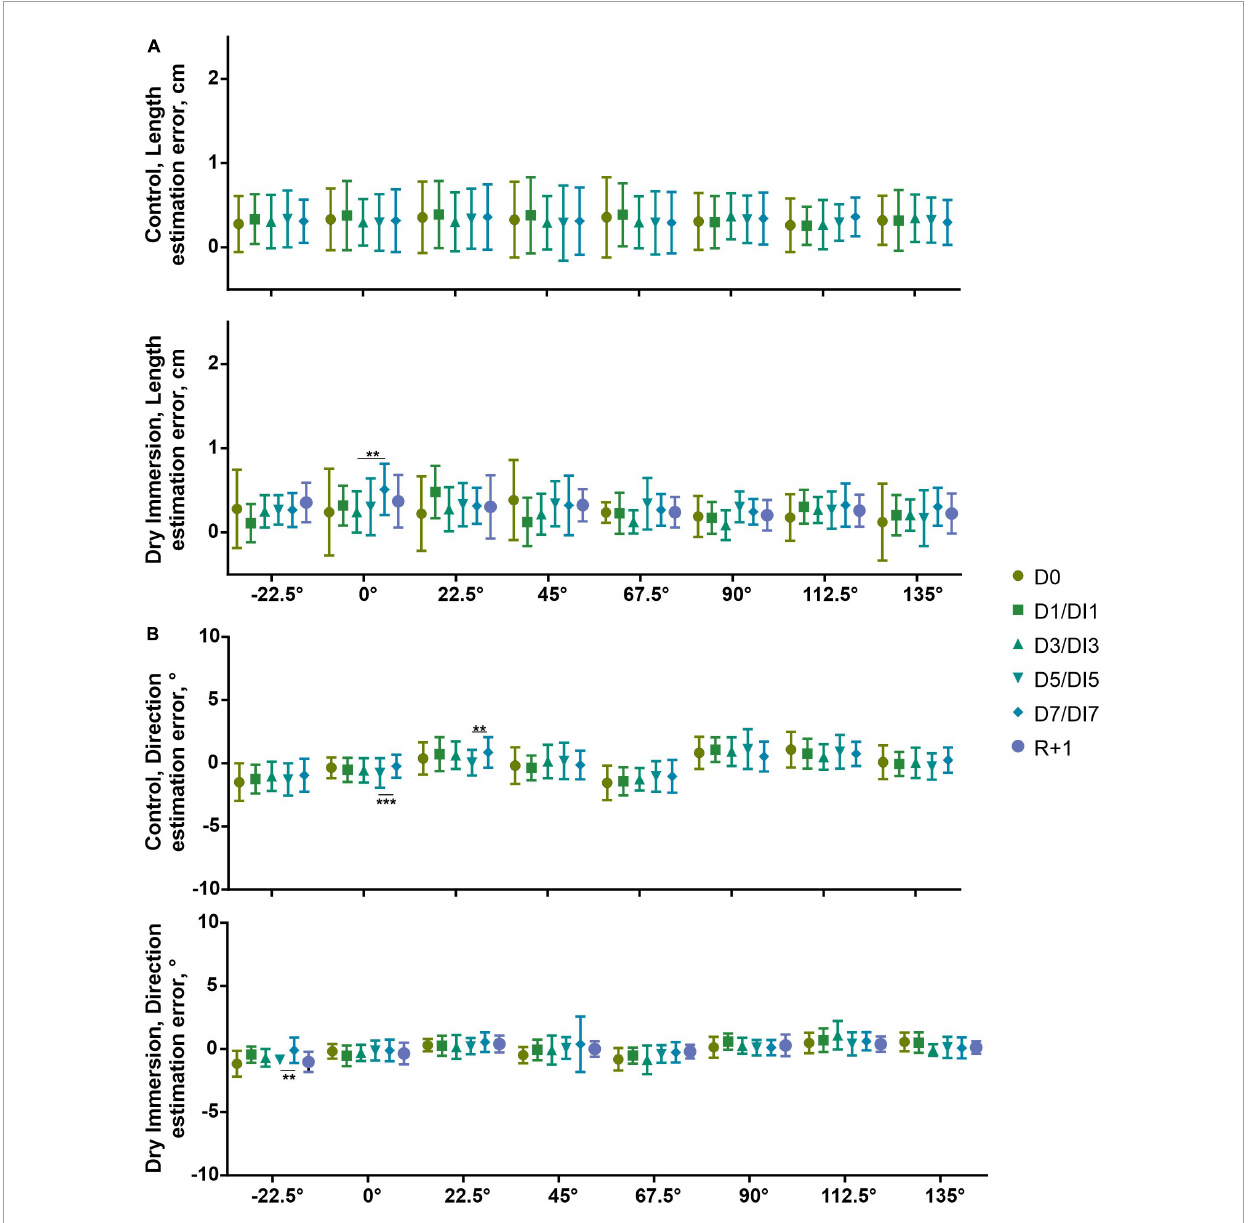
FIGURE2 Estimation of length (A) and direction (B) of segments of different orientation at memorization stage in control ( n = 22) and DI ( n = 10) groups. Abscissa-orientation of given segment. D0–1st day of measurements in control and DI groups. D1, D3, D5, and D7–2nd, 4th, 6th, and 7th day of measurements in the control group, respectively. These days correspond to DI1, DI3, DI5, and DI7–1st, 3rd, 5th, and 7th day of DI. R + 1–the measurement performed 1 day after the end of the DI procedure. Mean ± SD. ** p < 0.01, *** p < 0.001.